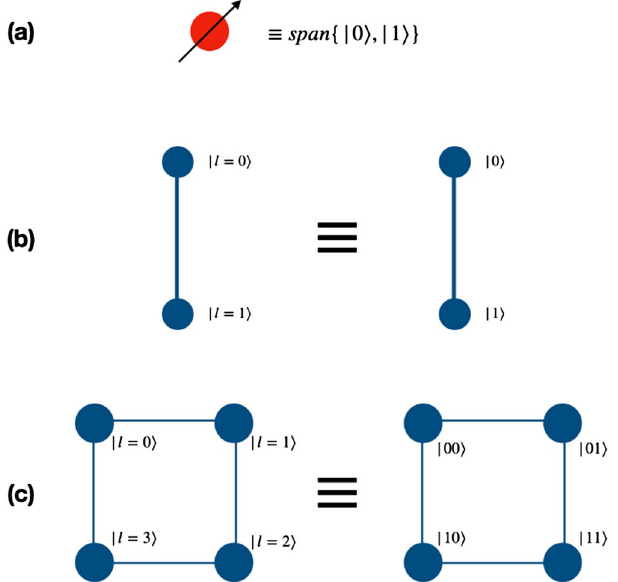
Figure 1. ( a ) Shows an illustration of a real qubit state. ( b ) Shows a mapping between the two states of position Hilbert space in one-dimension to the computational basis of second qubit in two qubit system, and ( c ) shows a mapping between the position Hilbert space in one-dimensional closed quantum walk state to the computational basis of the second and third qubits in the three qubit system. These two graphs for quantum walk form the building blocks for the scheme to perform computation using quantum